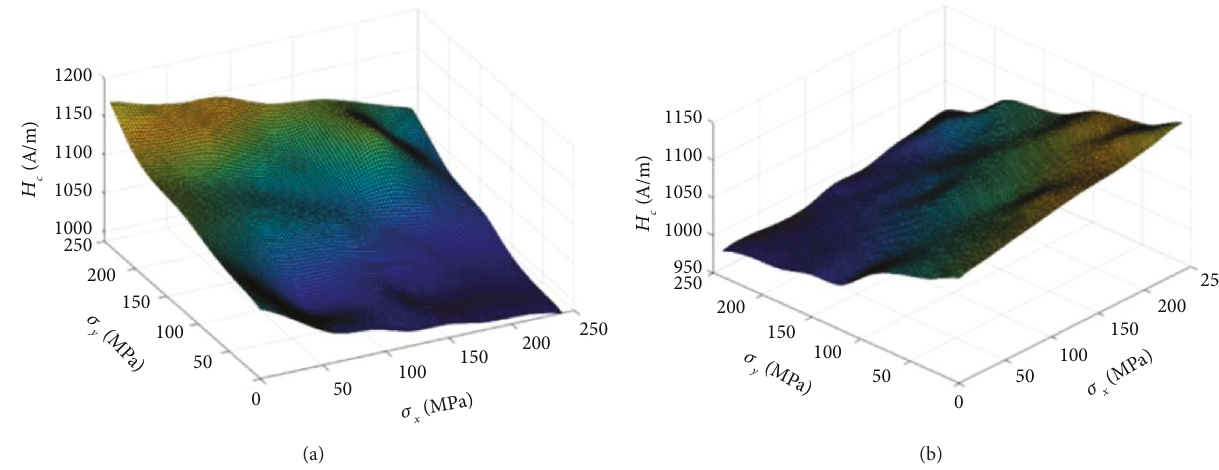
Figure 14: Three-dimensional diagram of test data of test piece 2. (a) X direction coercive force. (b) Coercive force in Y